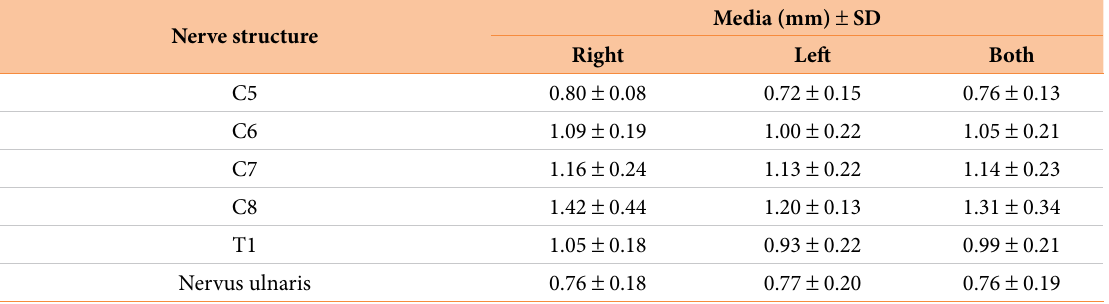
Table 1 - Distance of neural structures from the lateral border of the vertebral body (in mm) PB, 2022. The convergence point of C5 and C6 to originate TS 5.0 ±